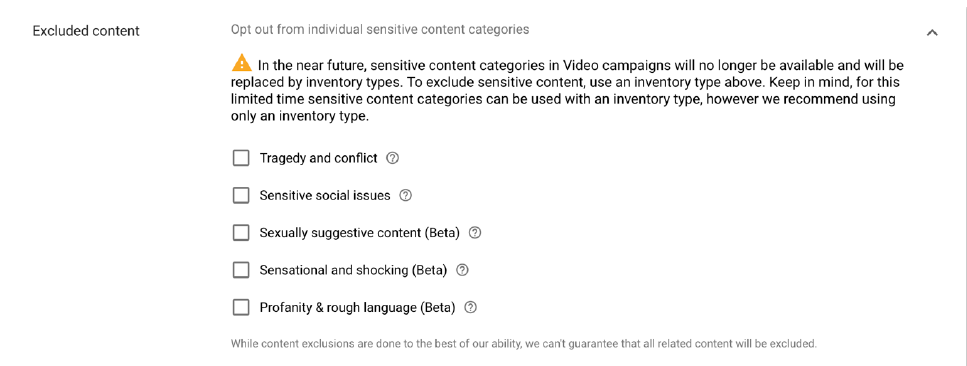
Figure 1: The categories of content (accessible through a Google Ads account) that potential advertisers can now exclude on YouTube.